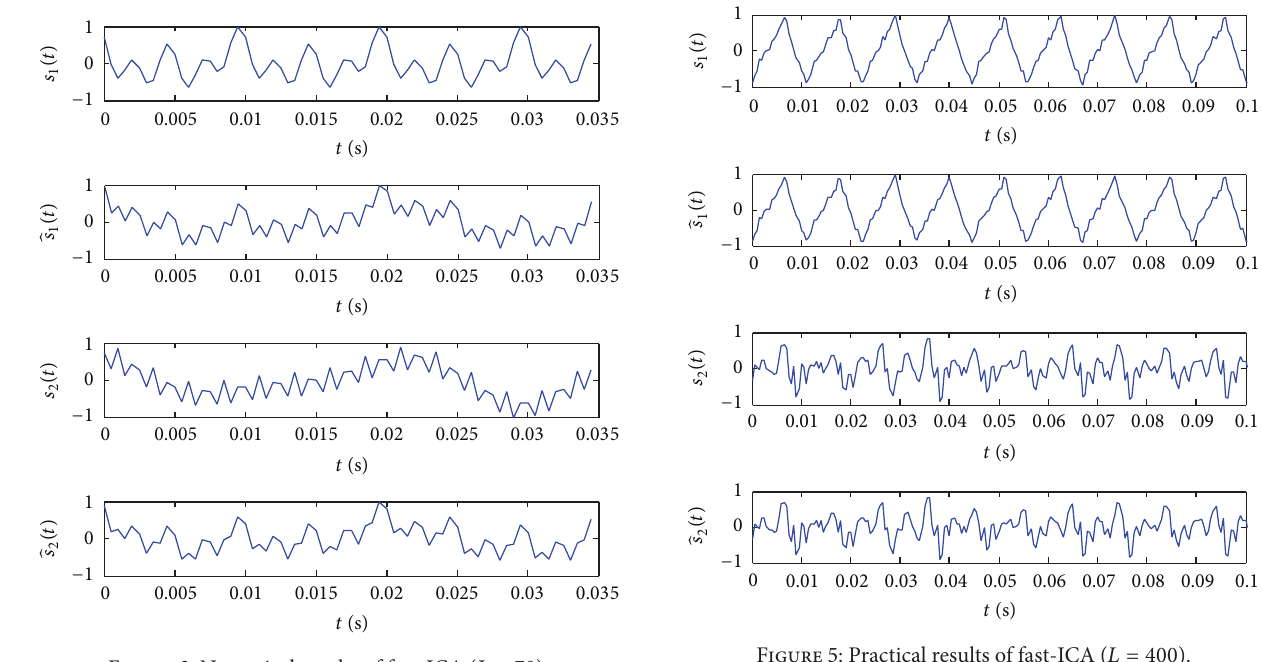
Figure 3: Numerical results of fast-ICA ( 𝐿 = 70 ).